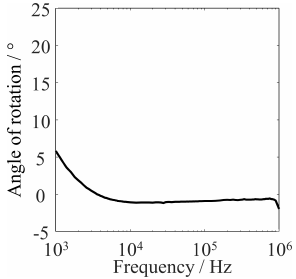
Figure 6. Angle between the major axis of the uncertainty ellipse and the real-part axis of the impedance plane, plotted against the fre- quency. The curve shows the data evaluation of the 10-fold emptied and refilled measuring cell with MUT 1. Each filling was measured 20 times.